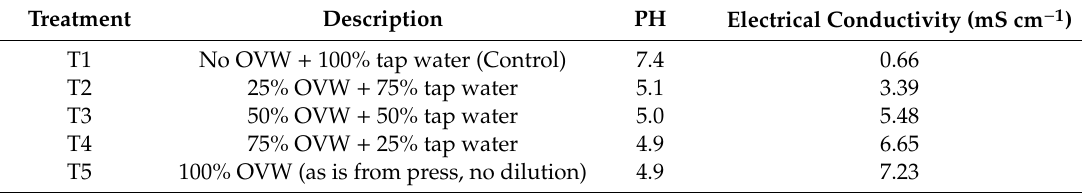
Figure 1. Picture showing petri dishes after treatment applications. From left to right, top row presents treatments 1–3 and bottom row presents treatments 4 and 5. Table 1. Composition, pH, and electrical conductivity of treatments used in Experiment 1.